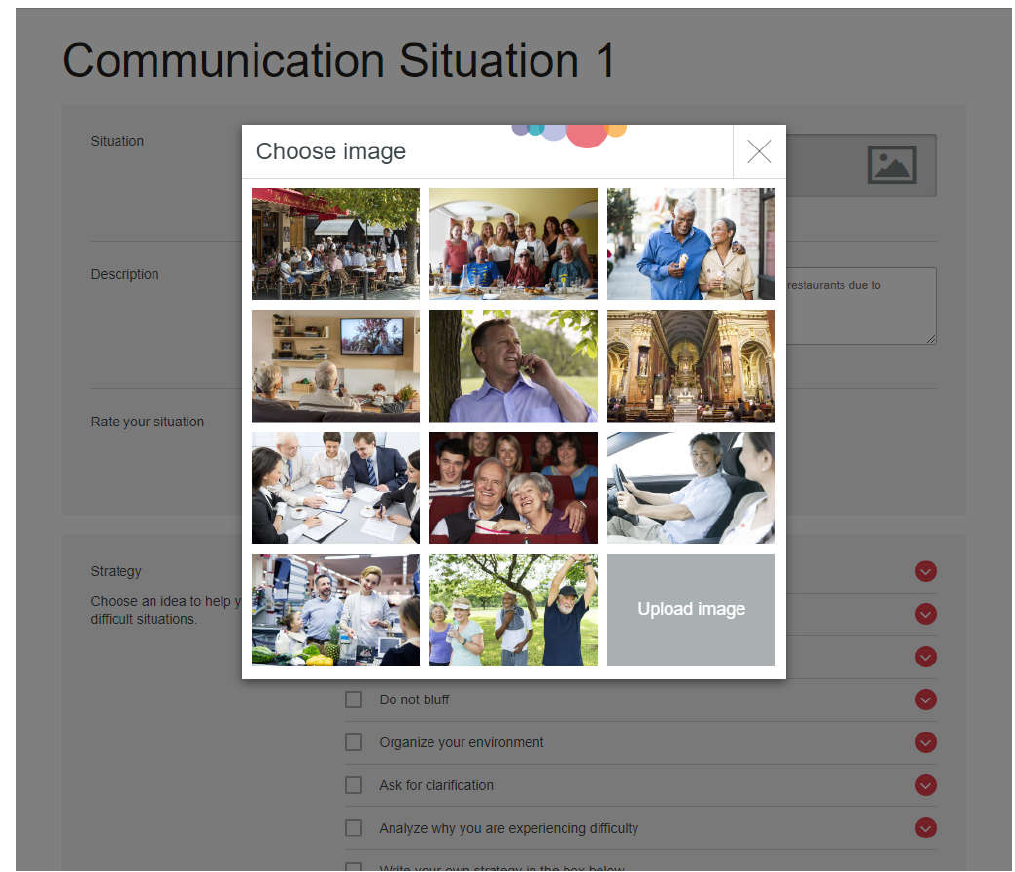
Figure 1. Sample screen shot of the online LWT.